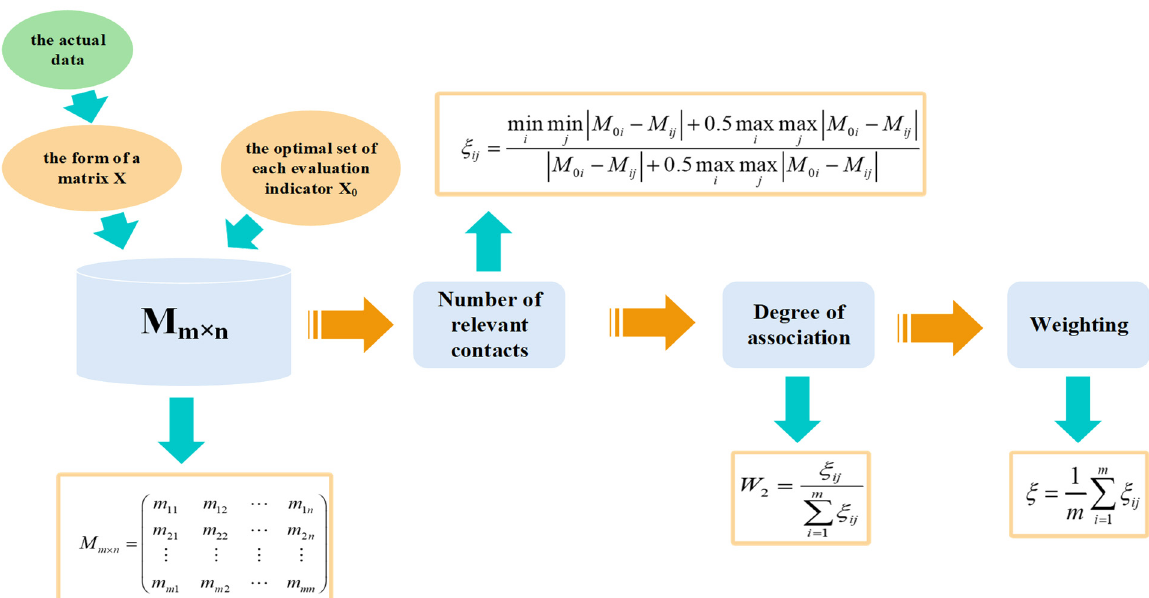
Figure 7. Calculating steps of GCA. Table 2. Weight of indicators.